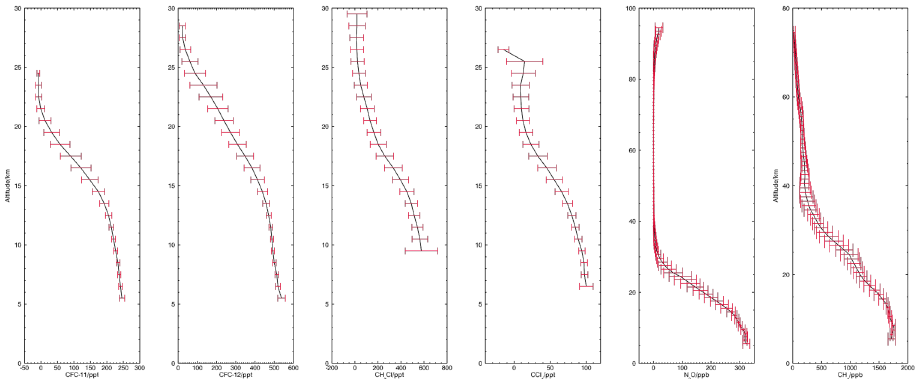
Figure C11 The mean vertical profile of CFC-11, CFC-12, CH3Cl, CH4 & N2O, calculated using data from 2009 between 60° and 75° South Fig. C12. The mean vertical profile of CFC-11, CFC-12, CH 3 Cl, CCl 4 , N 2 O and CH 4 , calculated using data from 2009 between 60 ◦ and 75 ◦ S.